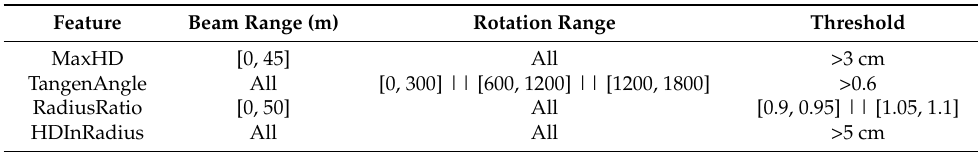
Table 1. The range and threshold for each feature.